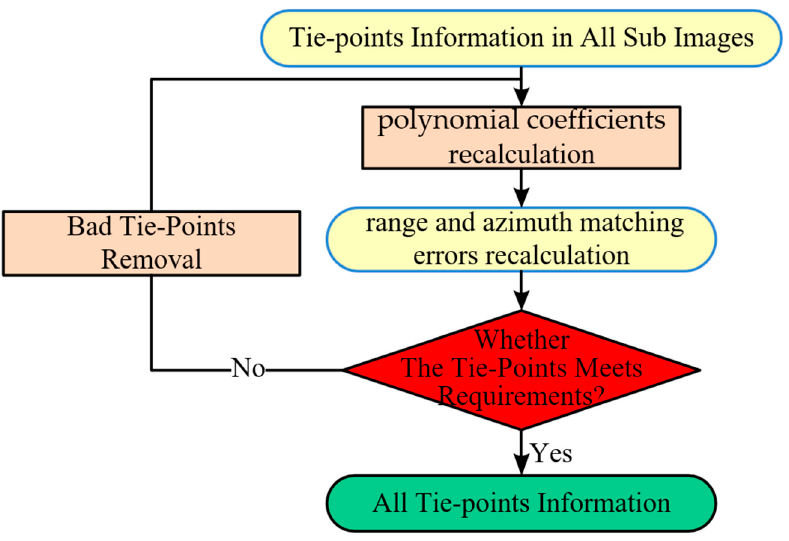
Figure 6. Diagram of filtering of tie-points.